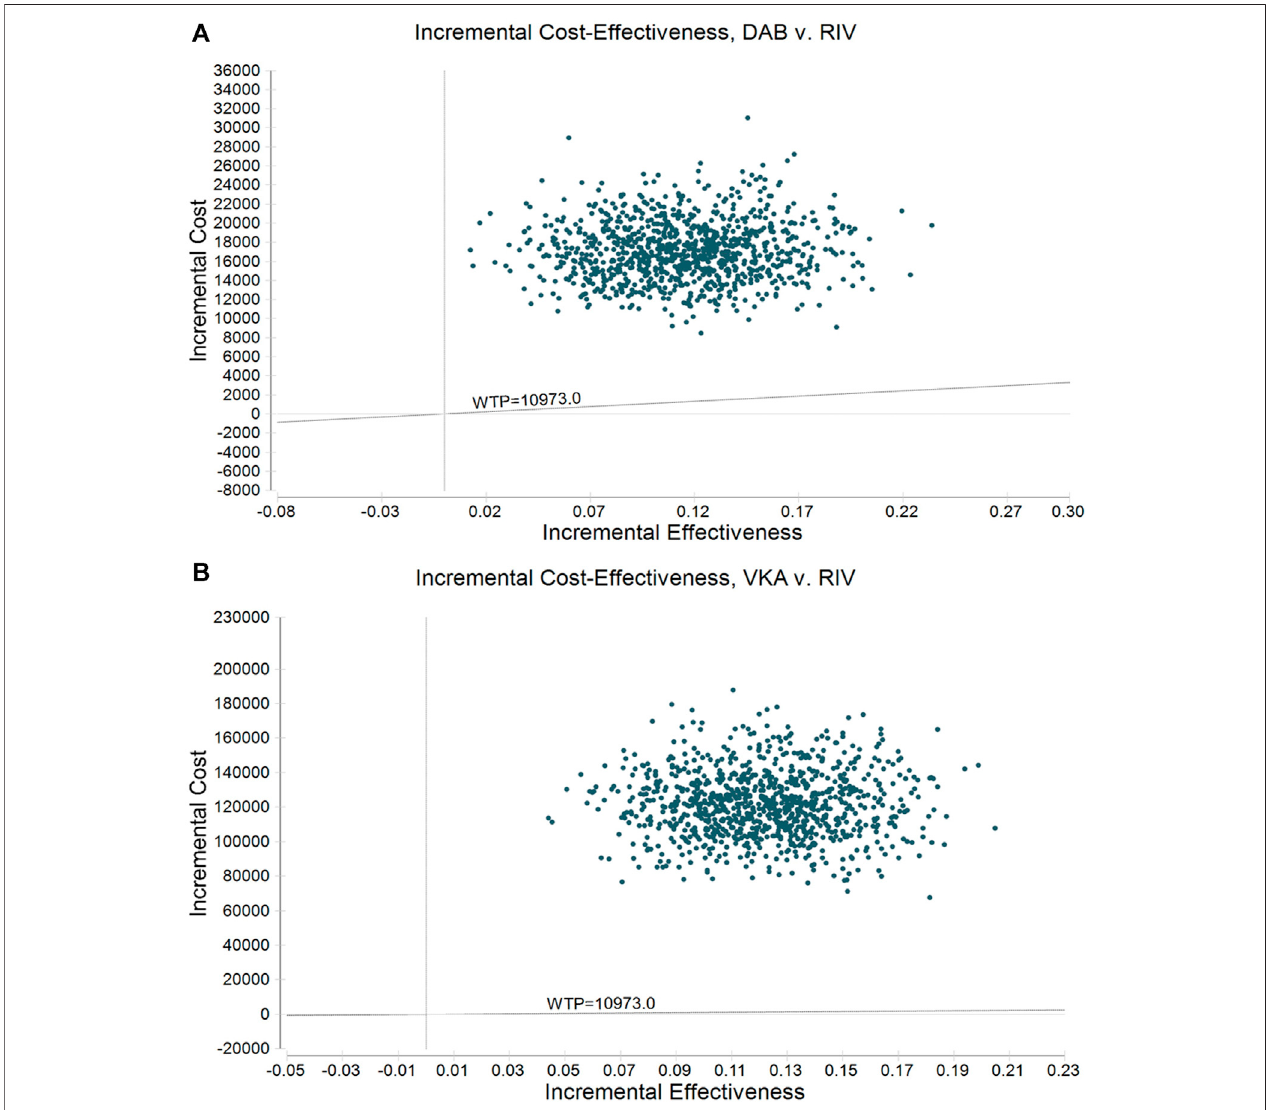
FIGURE 4 | Incremental cost-effectiveness scatter plot of probabilistic sensitivity analysis. (A) Dabigatran vs. rivaroxaban; (B) LMWH + VKA vs. rivaroxaban.